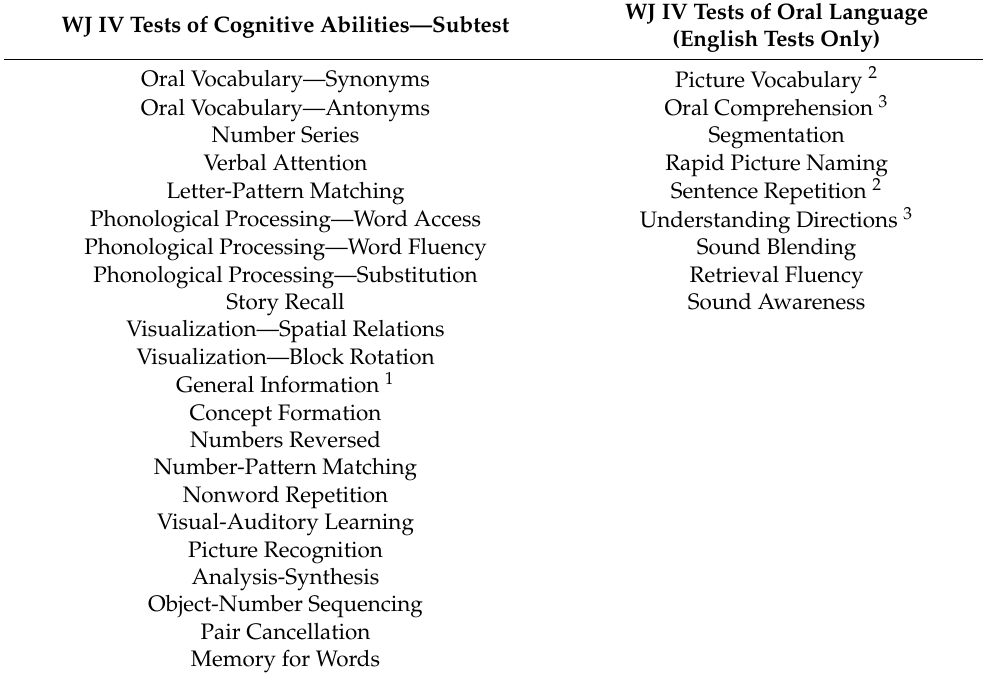
Table 1. List of WJ IV Tests of Cognitive Abilities and WJ IV Tests of Oral